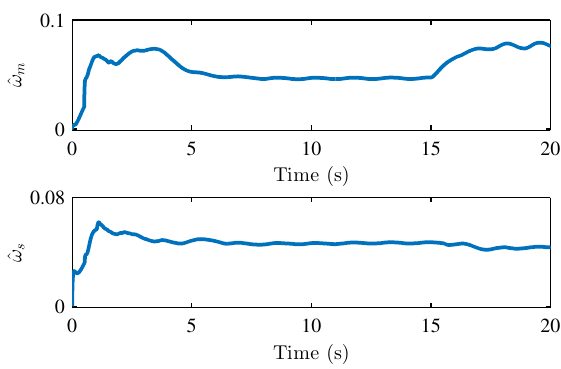
Figure 8. Adaptive parameters ˆ ω m and ˆ ω s .